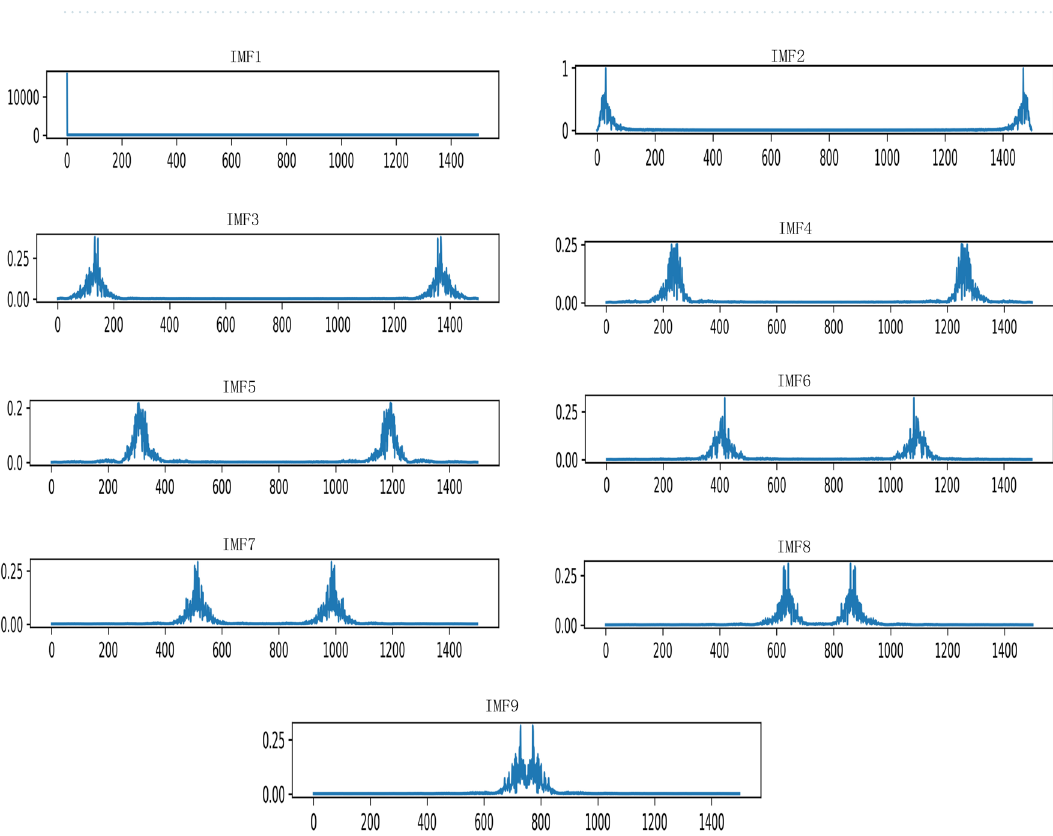
Figure 9. The center frequency diagram decomposed into 9